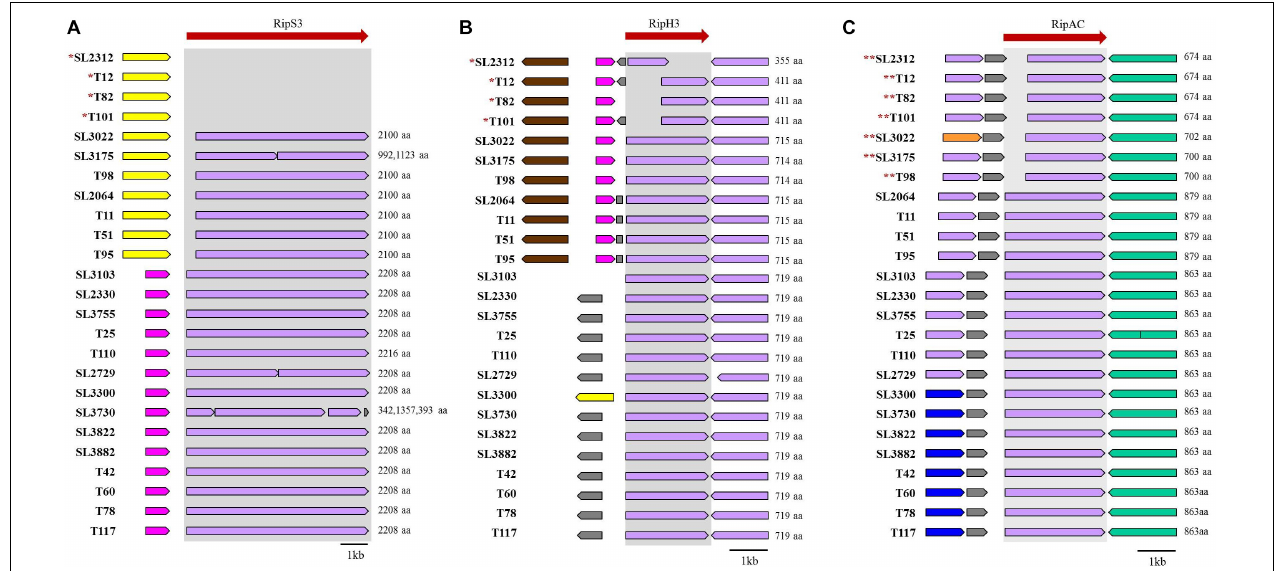
FIGURE 5 | Genetic regions of RipS3 (A) , RipH3 (B) , and RipAC (C) . ∗ non-pathogenic strains for tomato. ∗∗ non-pathogenic strains for eggplant.